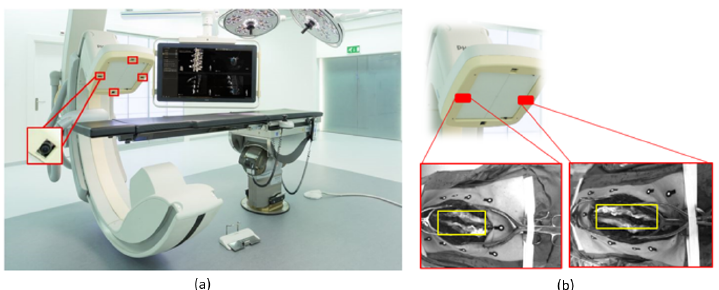
Figure 2. ( a ) The optical tracking system, four optical cameras are integrated in the flat panel of the X-ray detector (Philips Electronics B.V., Best, The Netherlands). ( b ) The optical cameras we used in this preliminary